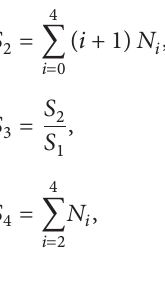
the original grayscale image and a low-pass version of the halftone image, it measures effectively the distortions to the low-frequency image content [14]. But Pei-Guo-PSNR is improper for measuring the high-frequency image